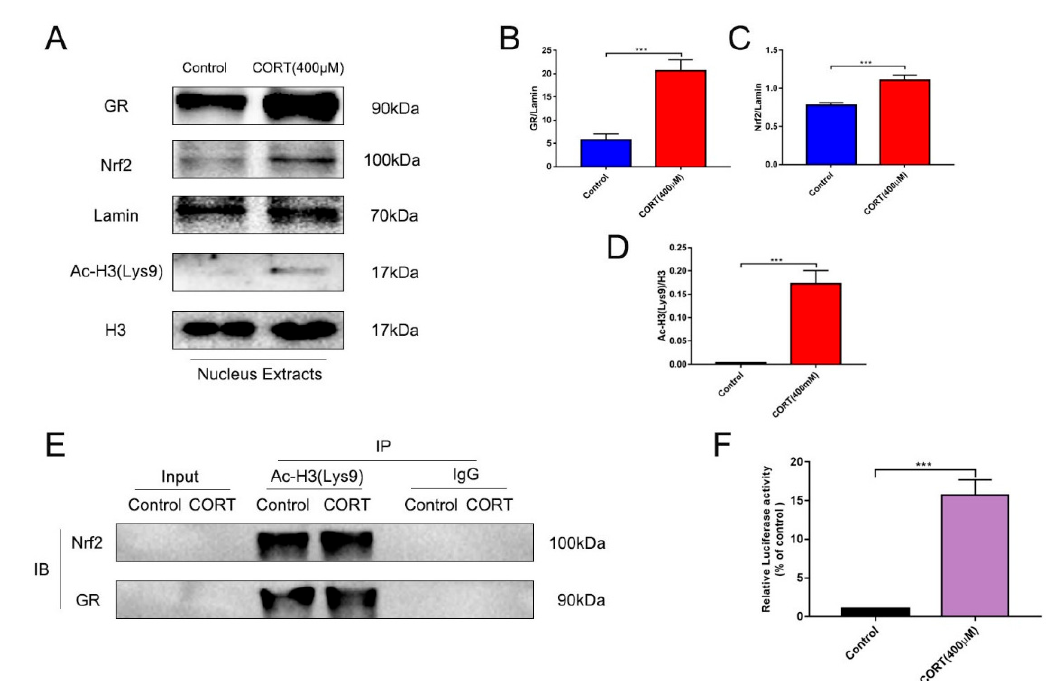
Figure 11. The relevant expression of nuclear proteins in HT22 cell nuclear lysates after cortisol (CORT) treatment for 3 h as assessed by western blotting and relative density analyses. ( A ) GR, Nrf2, Lamin, Ac-H3 (Lys9), and H3 expression in each group. Expression levels were quantitated by measuring band intensities using Image Lab software. The graphs indicate densitometric analyses using the expression ratios of ( B ) GR/Lamin, Nrf2/Lamin ( C ), and Ac-H3 (Lys9)/H3 ( D ). Data were between control (CORT 0 μ M) vs. CORT (400 μ M), and were analyzed by one-way analysis of variance. The results are expressed as the mean ± SD ( n = 3) in each independent experiment; *** P < 0.001. Co-immunoprecipitation of Ac-H3 (Lys9) with Nrf2 or GR from HT22 cells. Whole cell extracts (lanes 1, 2), immune precipitates generated with the Ac-H3 (Lys9) antibody (lanes 3, 4), and control IgG (lanes 5, 6) were immunoblotted with anti-Nrf2 or anti-GR antibody with or without CORT treatment. ( E ). Nrf2 transcriptional activity in HT22 cells with or without CORT treatment. ( F ). Data were between control vs. CORT (400 μ M), and were analyzed by one-way analysis of variance. The results are expressed as the mean ± SD ( n = 3) in each independent experiment; *** P < 0.001.